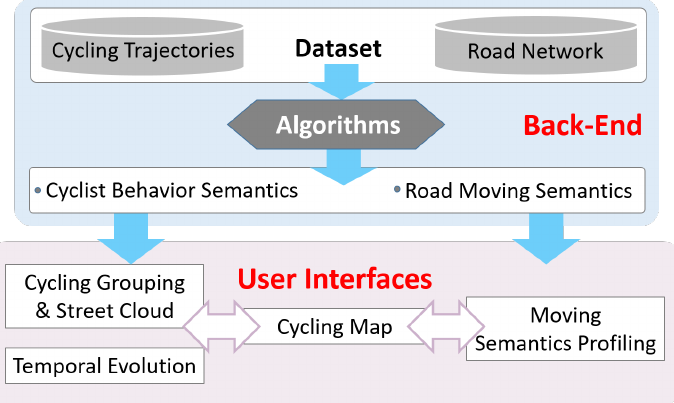
Figure 1. Overview of the system